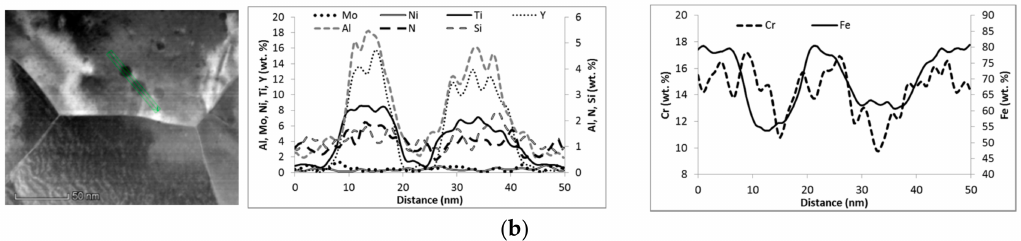
Figure 7. STEM-EDX maps and the line scan across two coarser precipitates of Air720: ( a ) Maps showing enrichment of Cr, Ti, Mo, and Ni at the grain boundary; ( b ) The line shows enrichment of the particles with Al, Y, N, Ti, Si, and depletion by Fe, Cr.